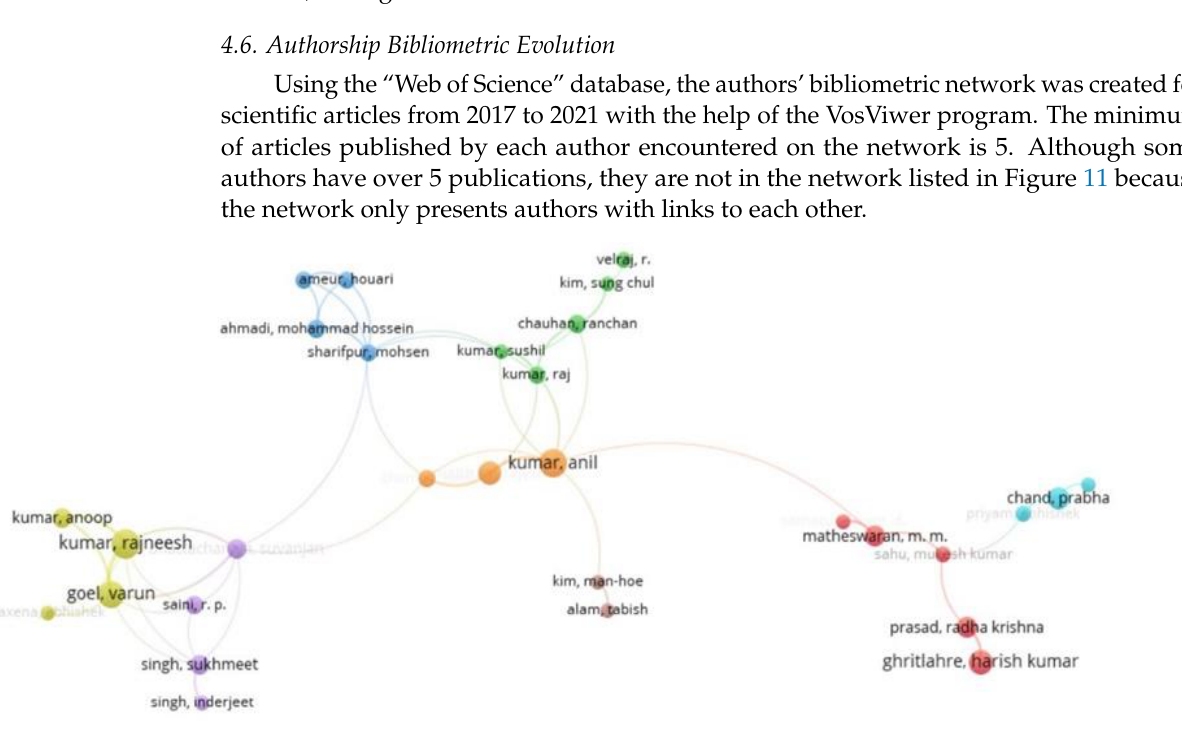
Figure 11. Solar air heaters authors’ cooperation network.